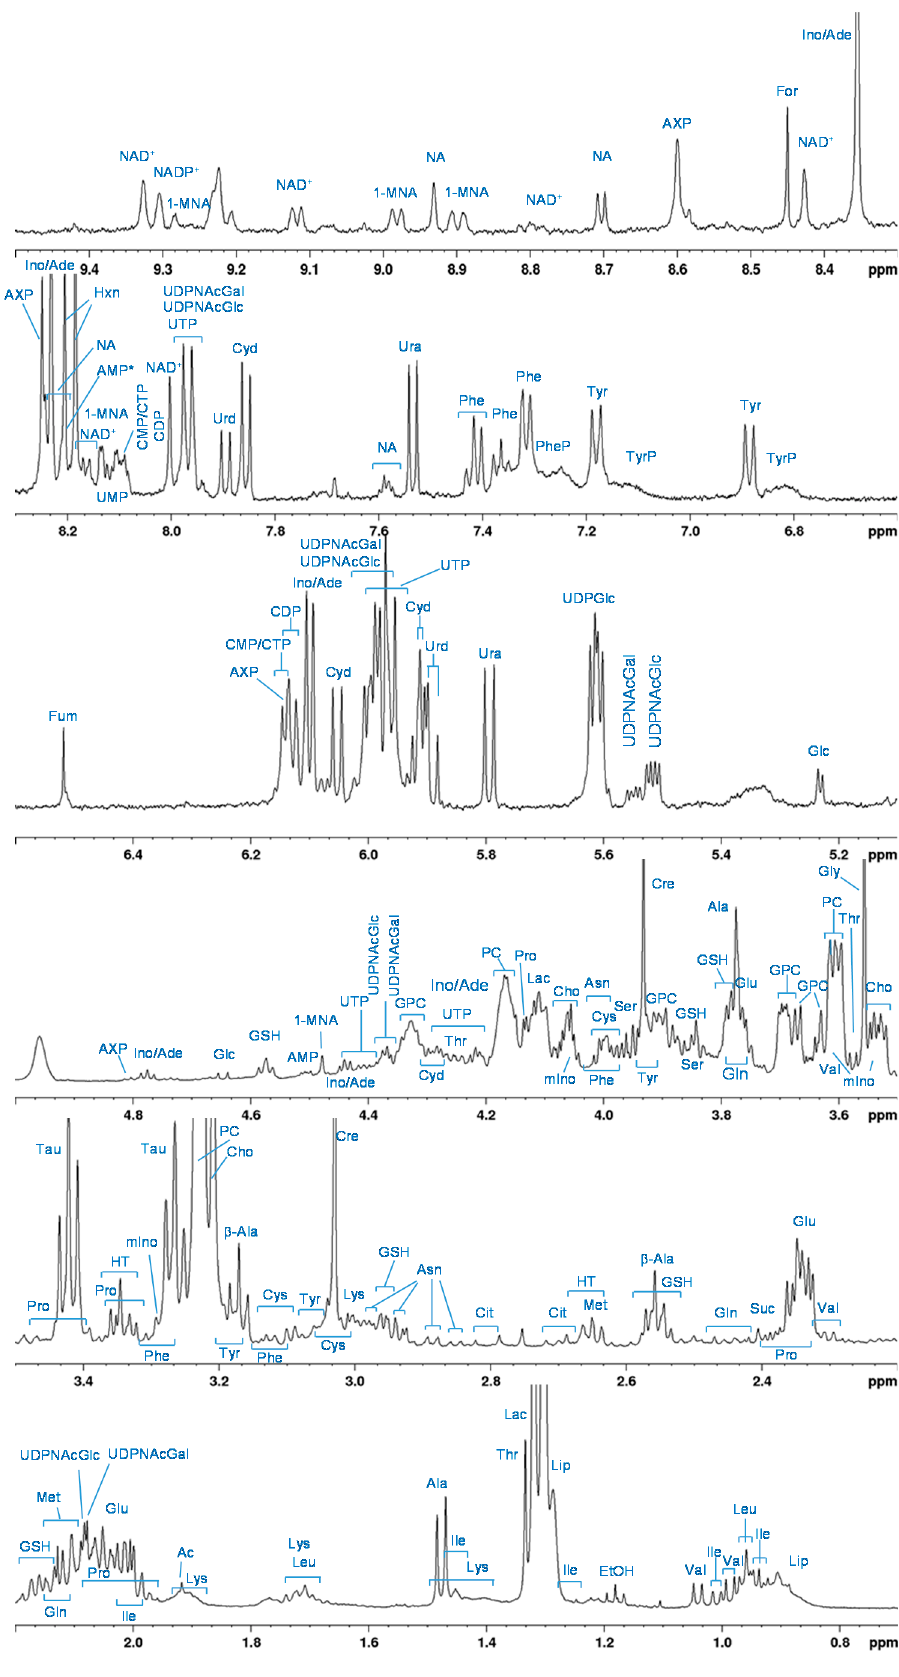
Figure 2. 1 H HR-MAS-PROJECT sum spectrum of A24 cell suspensions in PBS (T = 276 K) with resonance assignments. Spectral regions of 5–10 ppm were scaled up by a factor of 10.